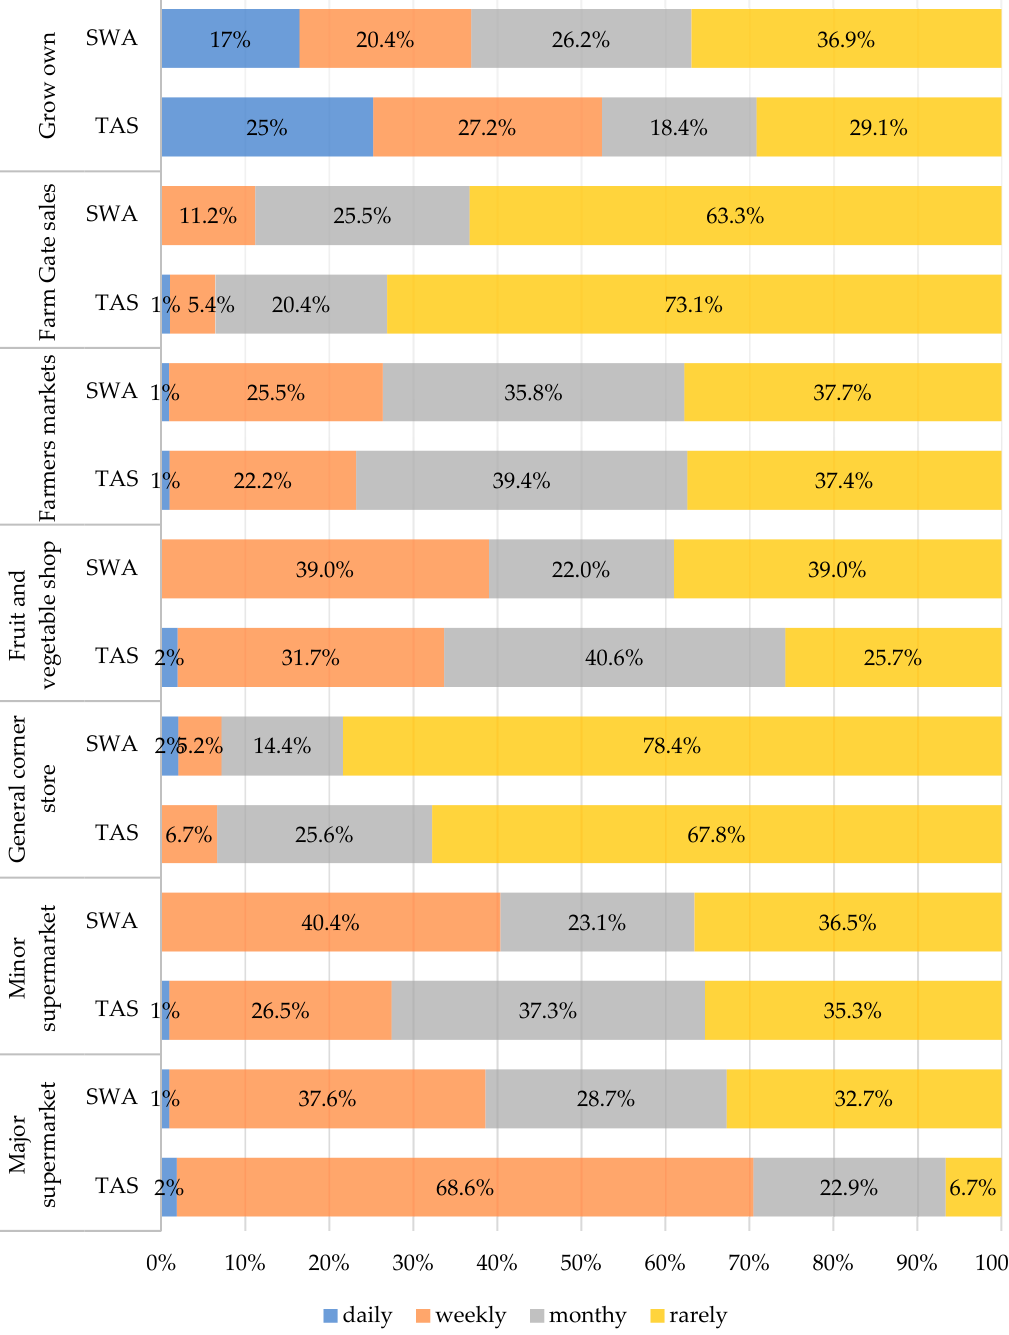
Figure 3. Frequency of shopping for regionally grown fresh fruits and vegetables from various food outlets in (a) Tasmania (TAS) and (b) South Western Australia (SWA).